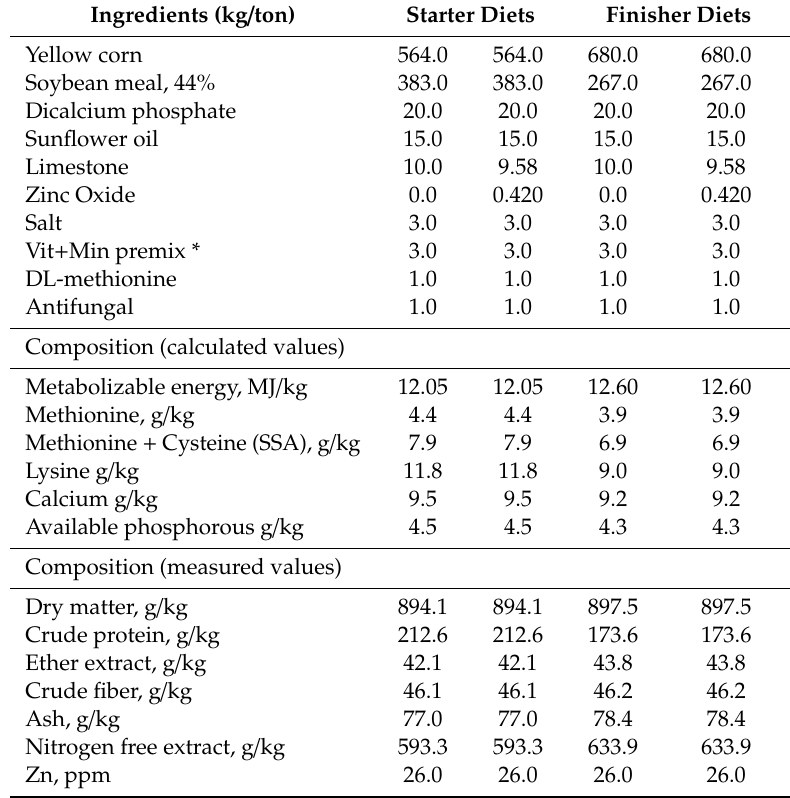
Table 1. Ingredients and chemical-nutritional characteristics of the basal diets fed to White Pekin ducks during the starter (1–35 days of age) and the finisher (36–56 days)